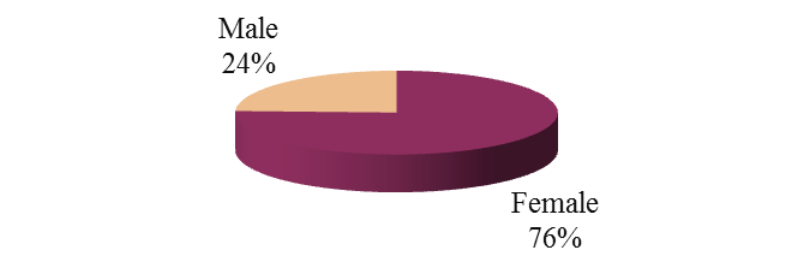
Figure 4. Students’